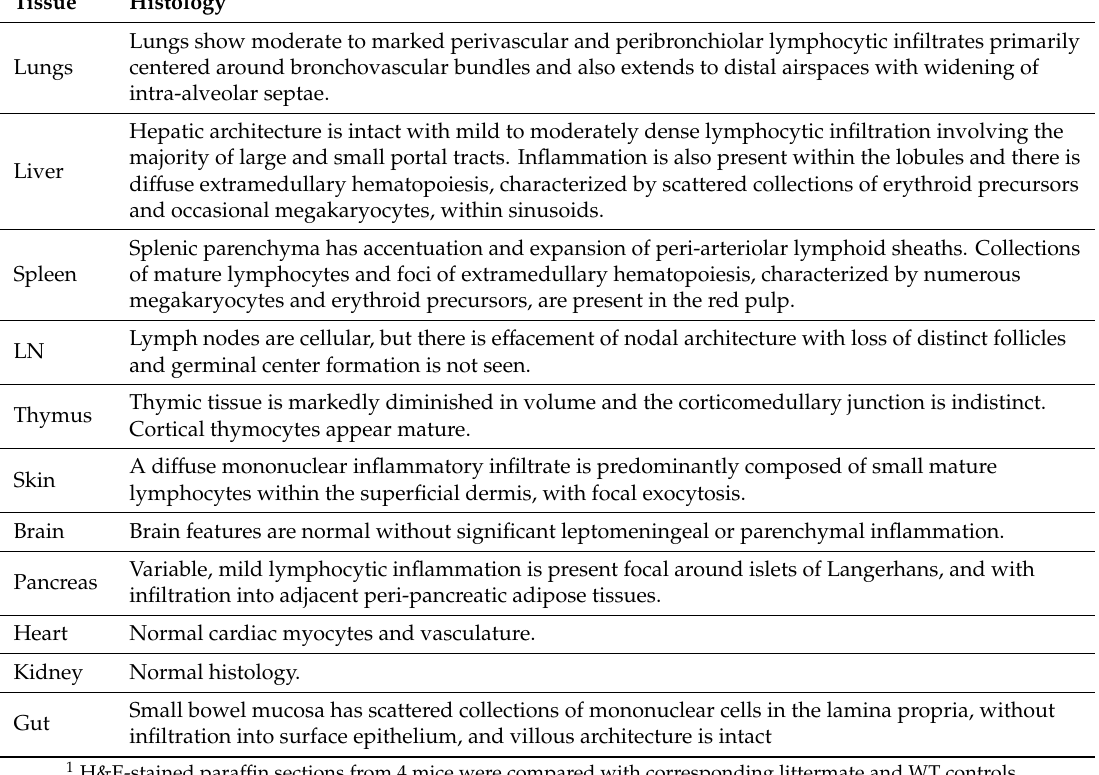
Table 1. Histopathology of tissues from male Foxp3 cre GCN5 flfl PCAF − / − mice (3 wks of age) 1